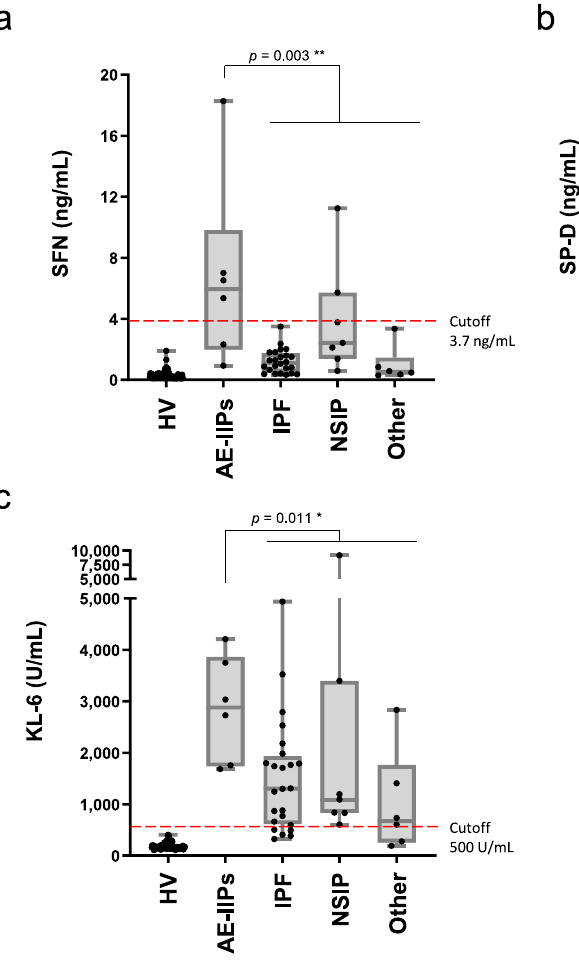
Fig. 4 | Serum levels of SFN and known biomarkers in idiopathic interstitial pneumonias. Thedistributionsof SFN ( a ), SP-D ( b ),andKL-6( c )areshowninbox- plot graphs. Numbers of samples: HV ( n =77), AE-IIPs ( n =6), IPF ( n =24), NSIP ( n =7), Other ( n =6). The boxes indicate interquartile ranges (75% and 25%) and medians; whiskers show min and max values. Differences between the two groups were compared by a two-tailed Mann – Whitney U -test (unadjusted): * p <0.05;